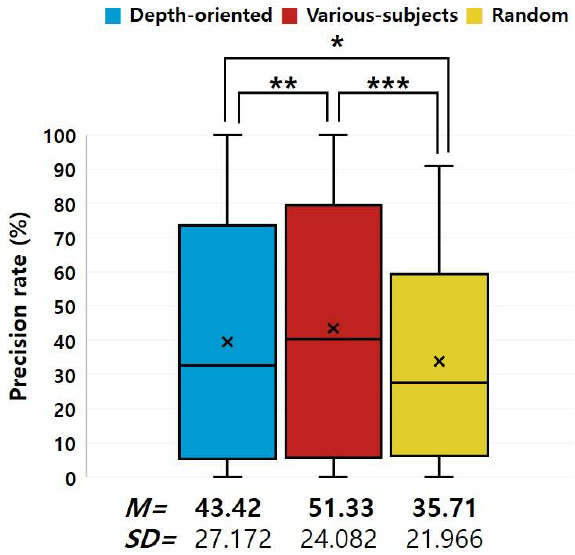
Figure 5. Precision rate of prior interested topic selected during the turn taking process.